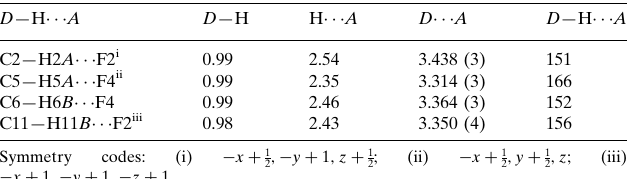
Hydrogen-bond geometry (A˚ , (cid:4)